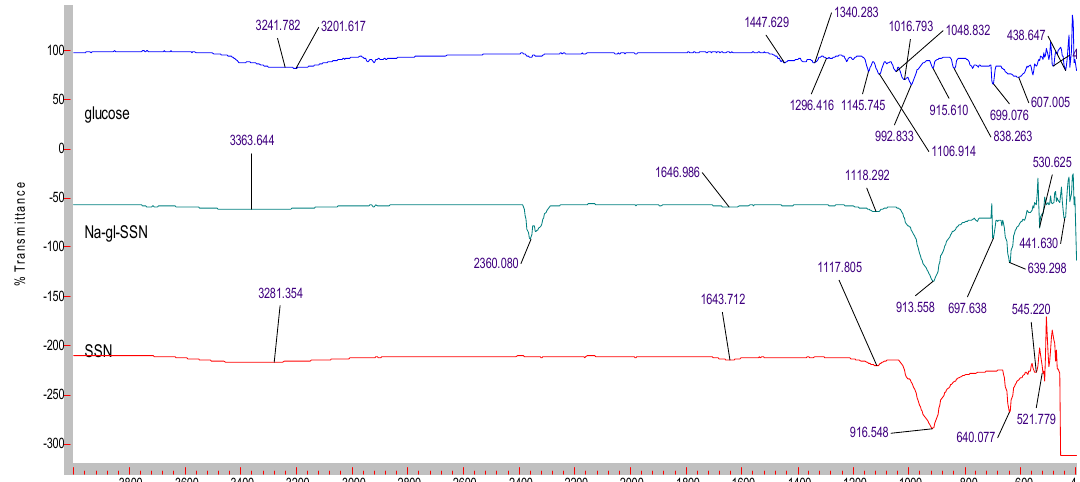
Figure 7. FTIR spectra for free glucose, SSNs (formed using 60 mM of SrCl 2 and and 10 mM of Na 2 SO 3 ) and Na-Glc-SSNs (formed by adding 60 mM of SrCl 2 , 300 mM of NaCl, 200 mM of glucose and 10 mM of Na 2 SO 3 ).